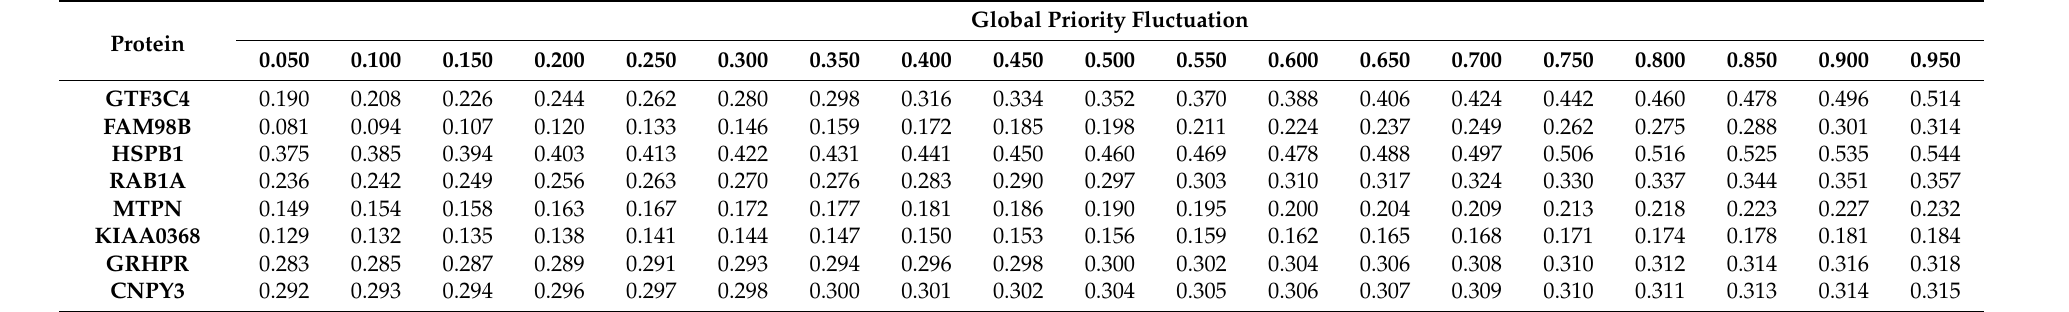
Table 5. The fluctuation in the global priority of the alternatives when minor variations are done to the criterion position in F t (solubility alteration)